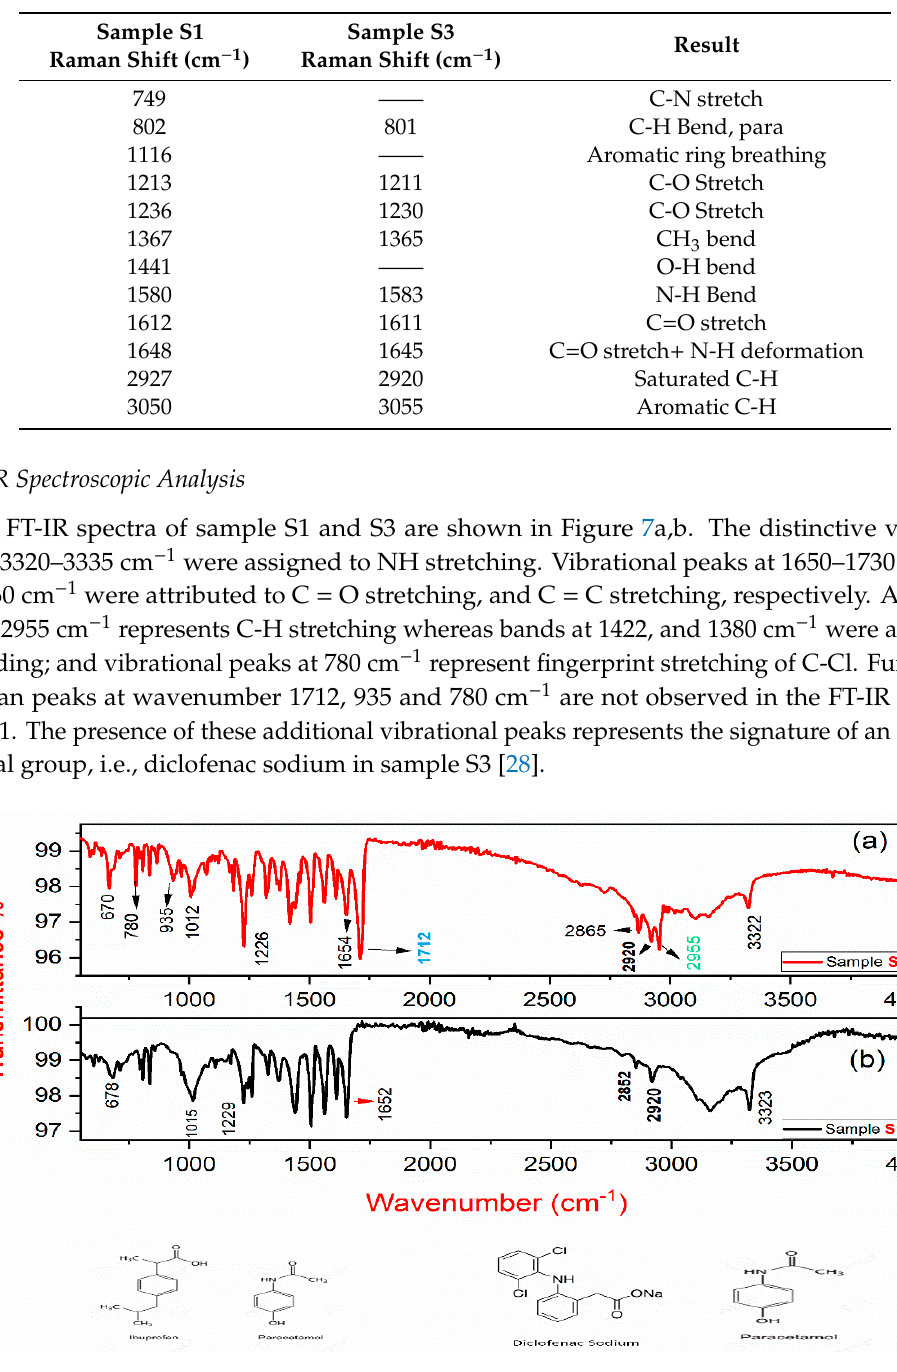
Table 2. Observed vibrational modes in the Raman spectra of sample S1 and S3.